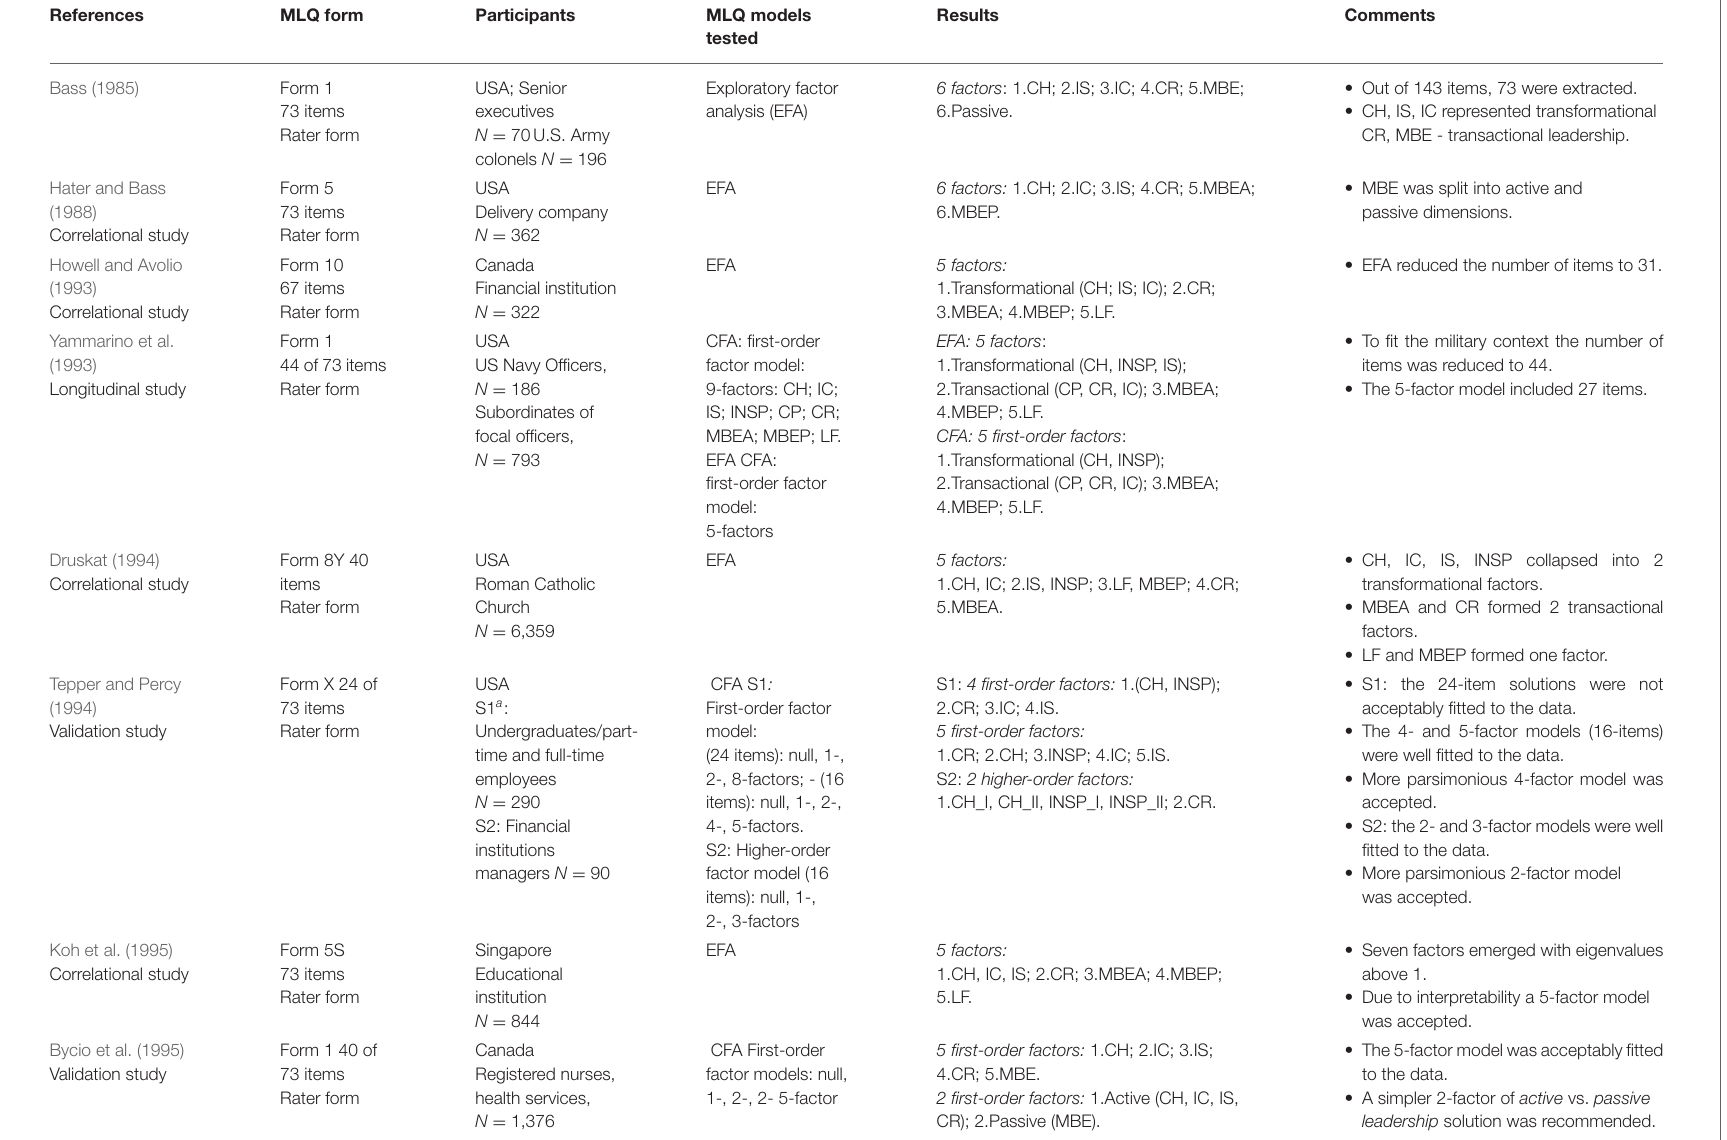
TABLE 1 | Factor structure of the MLQ – review of